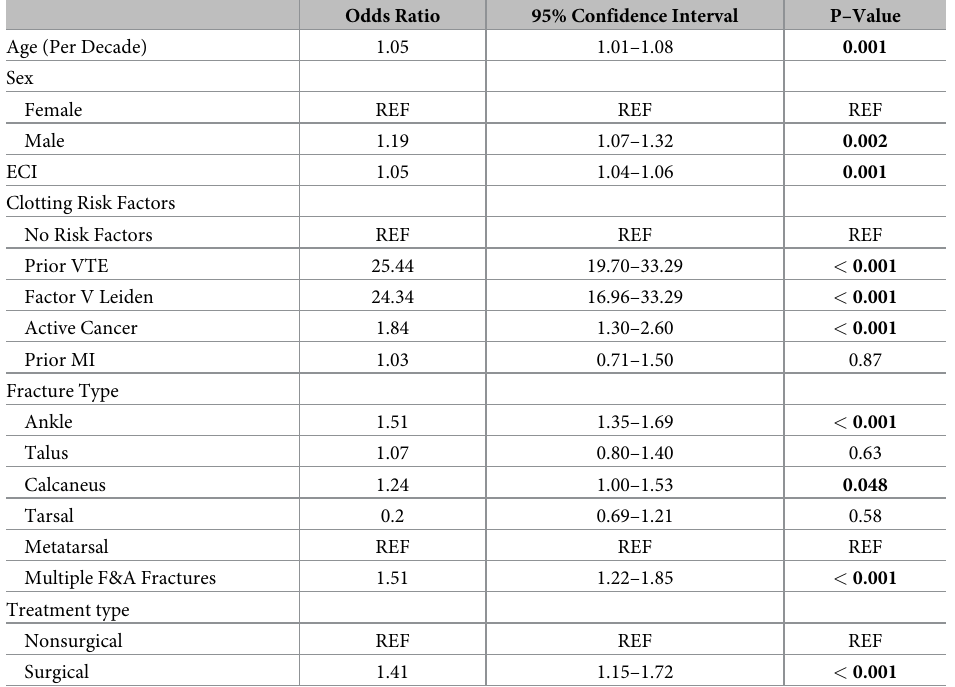
Table 2. Multivariate analyses of risk factors for VTEs after foot or ankle